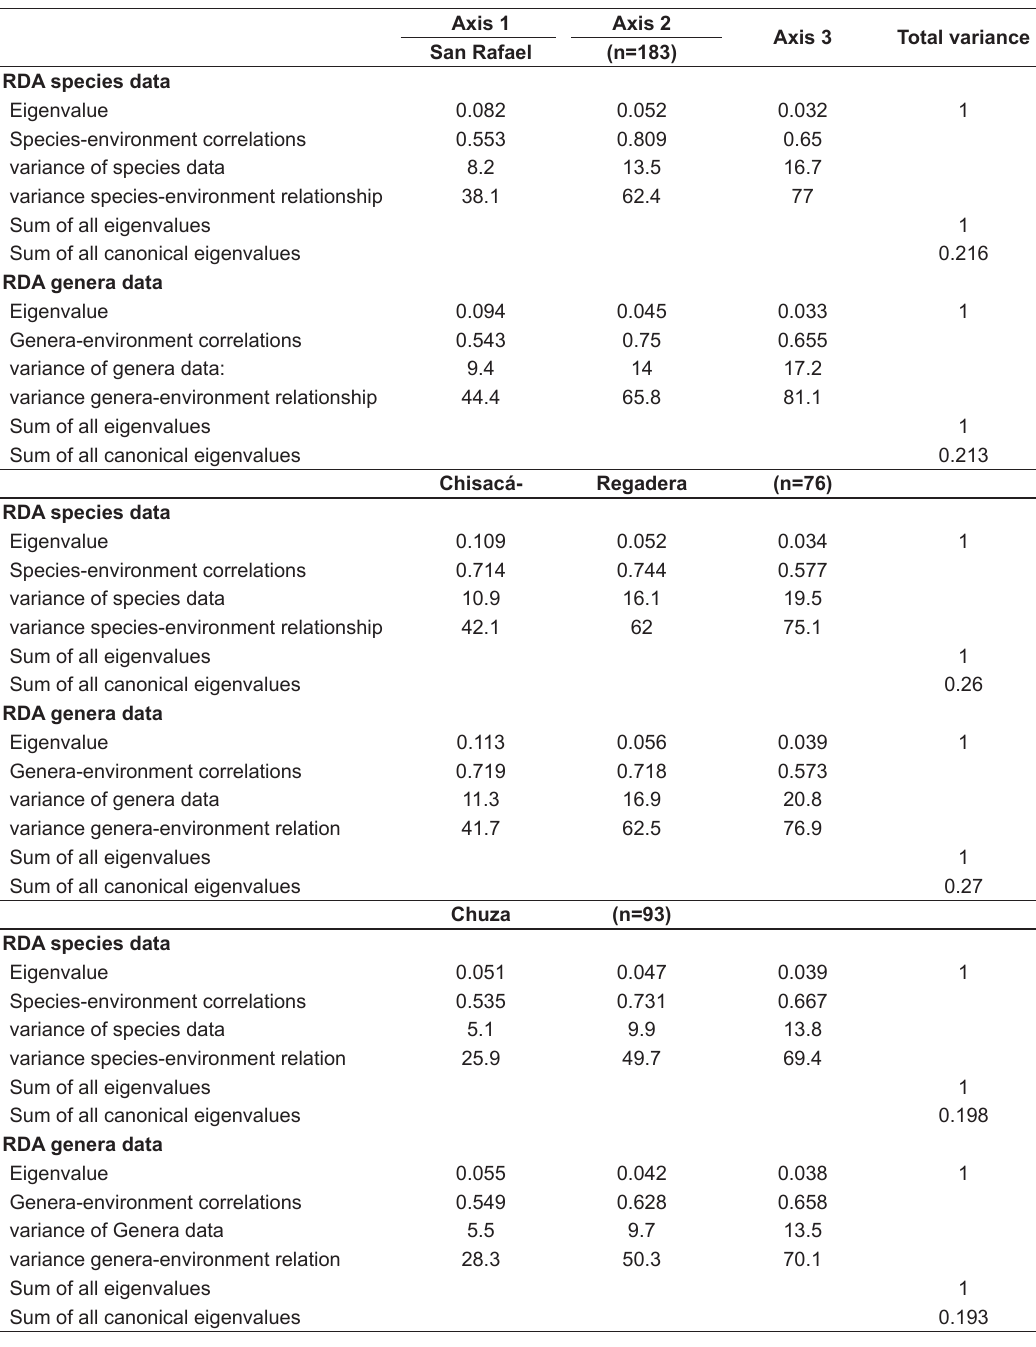
Table 5. Summary of the first three axes of the Redundancy Analysis carried out for species and genera groups data in each